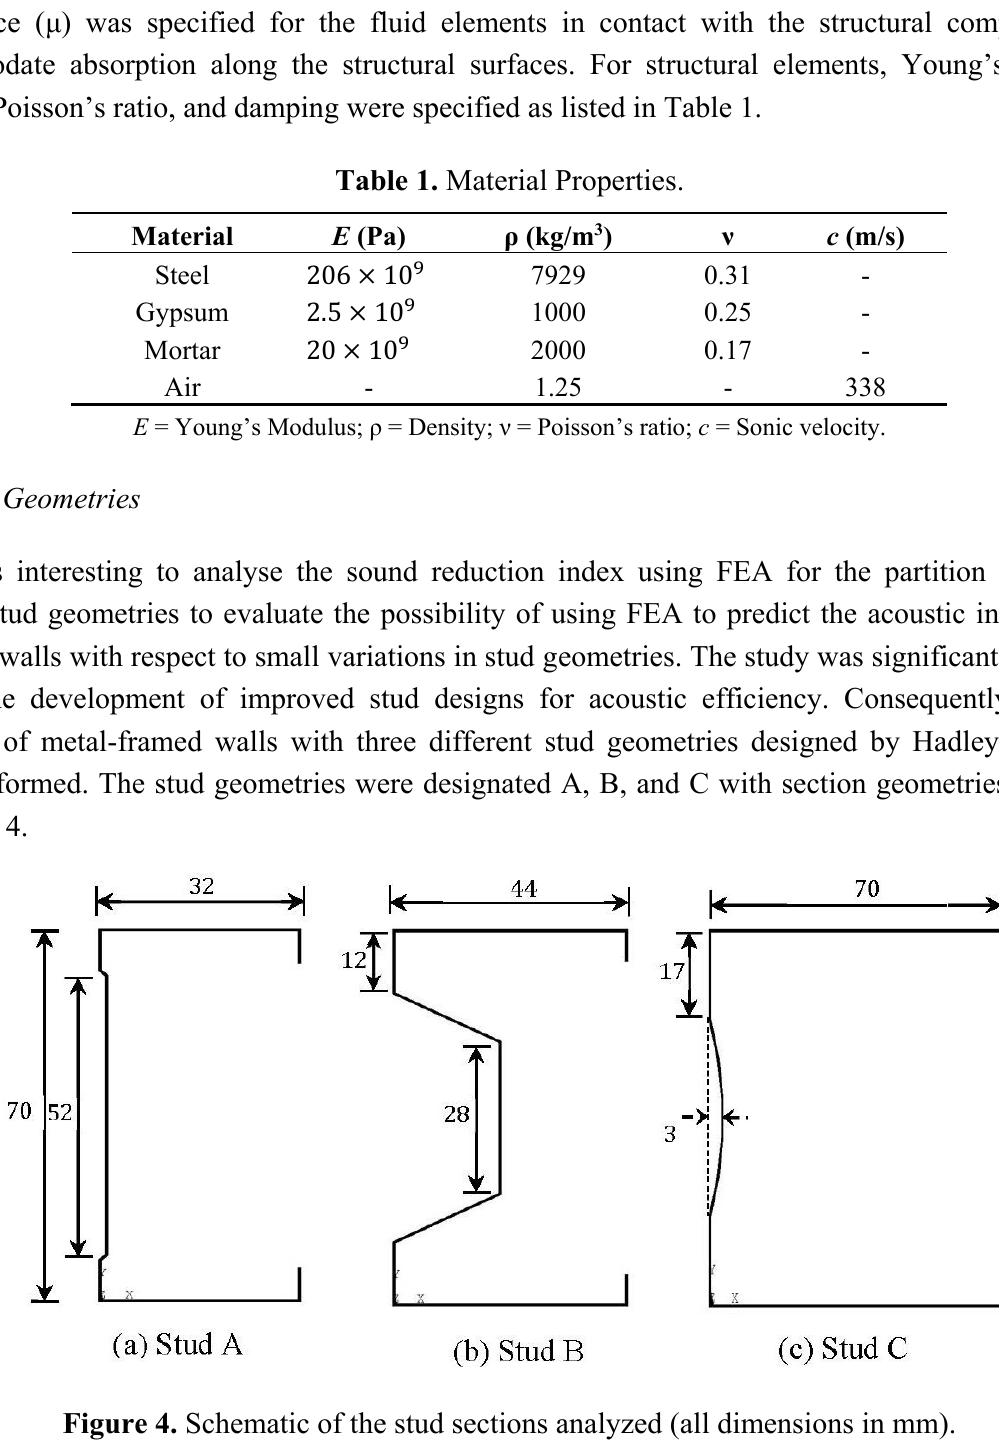
Figure 4. Schematic of the stud sections analyzed (all dimensions in